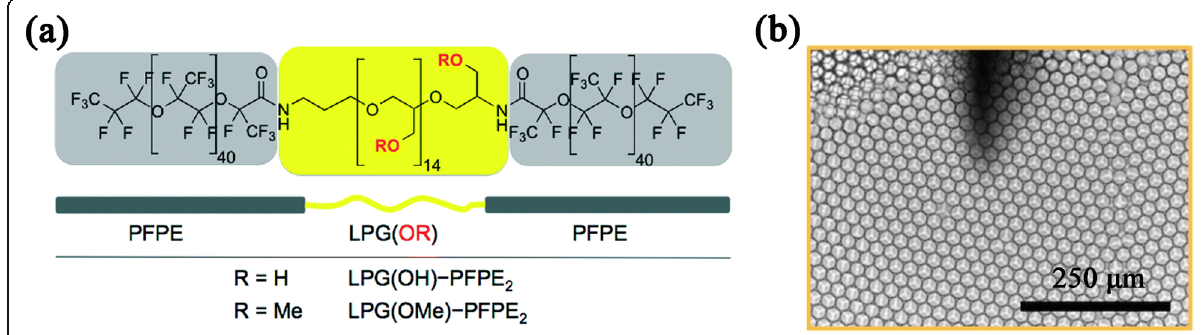
Fig. 3 Chemical structure of LPG (OH) and LPG (OMe) ( a ); W/O microemulsion stabilized with LPG (OMe)-PFPE2 that remained stable when mechanical stress was applied ( b ) [73]. Copyright 2016, Royal Society of Chemistry